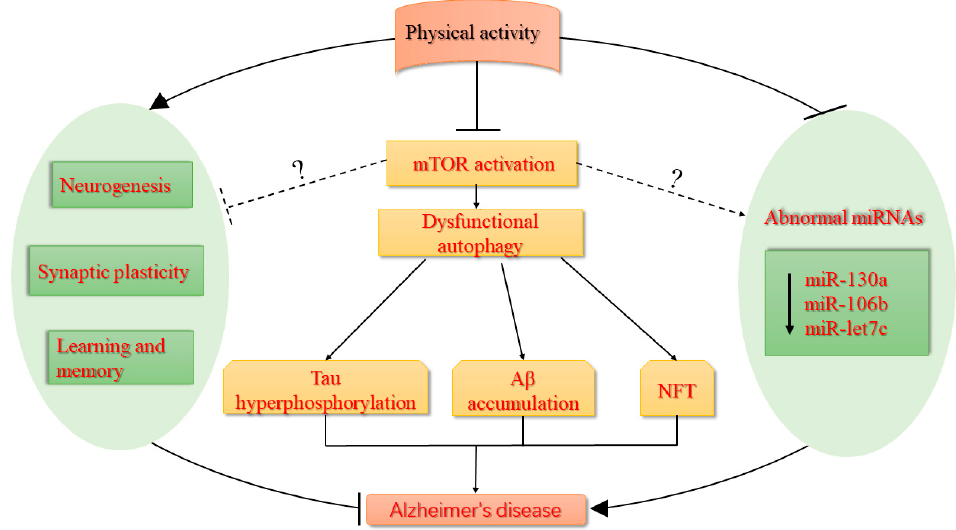
Figure 1. Physical activity as an mTOR suppressor can alleviate cognitive dysfunction and rescue abnormal miRNAs in AD for regulating functional status of autophagy, tau hyperphosphorylation, and the accumulation of A β and NFTs, thus accomplishing the mitigation of AD. Meanwhile, mTOR could be considered as the preventive and therapeutic target to develop novel and effective intervention strategies for AD and other neurodegenerative diseases. The solid arrows present the activation and the dotted arrows present the suppression, as well as question symbols presents the uncertainty.